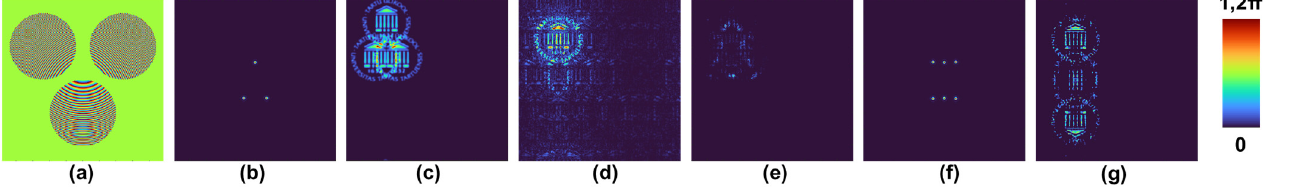
Figure 6. ( a ) Phase image of LADISA with three sub-apertures, ( b ) the PSF and ( c ) object intensity distribution of the test object. Reconstruction results of LADISA using ( d ) NLR and ( e ) LRRA. Image of ( f ) PSF and ( g ) reconstruction result from LRRA after post-processing by converting the asymmetric distributions into symmetric ones.